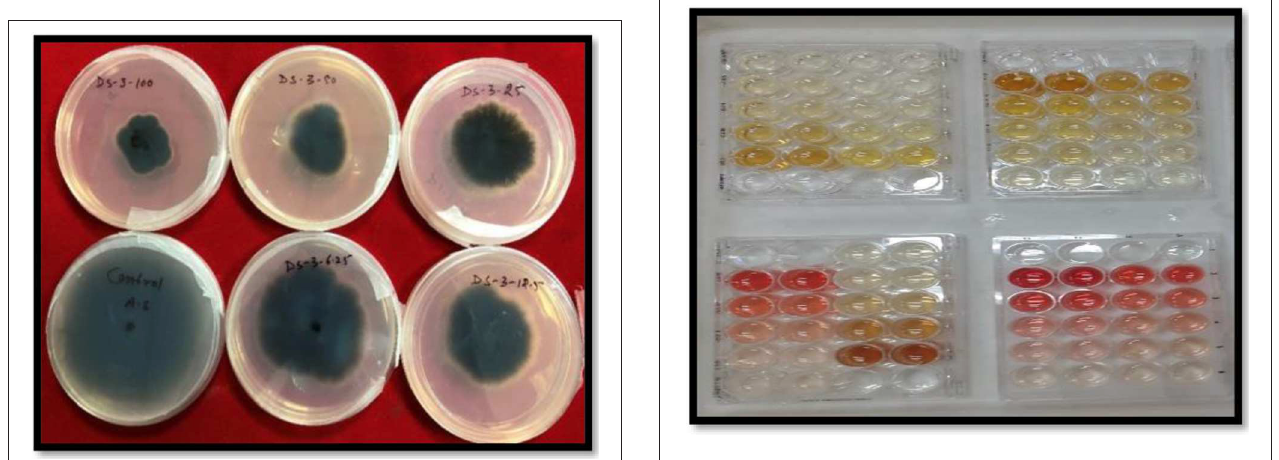
FIGURE 3 | In-vitro nematicidal bioassay well culture plate containing nematode suspension (1mL) and different concentrations (1mL) of test